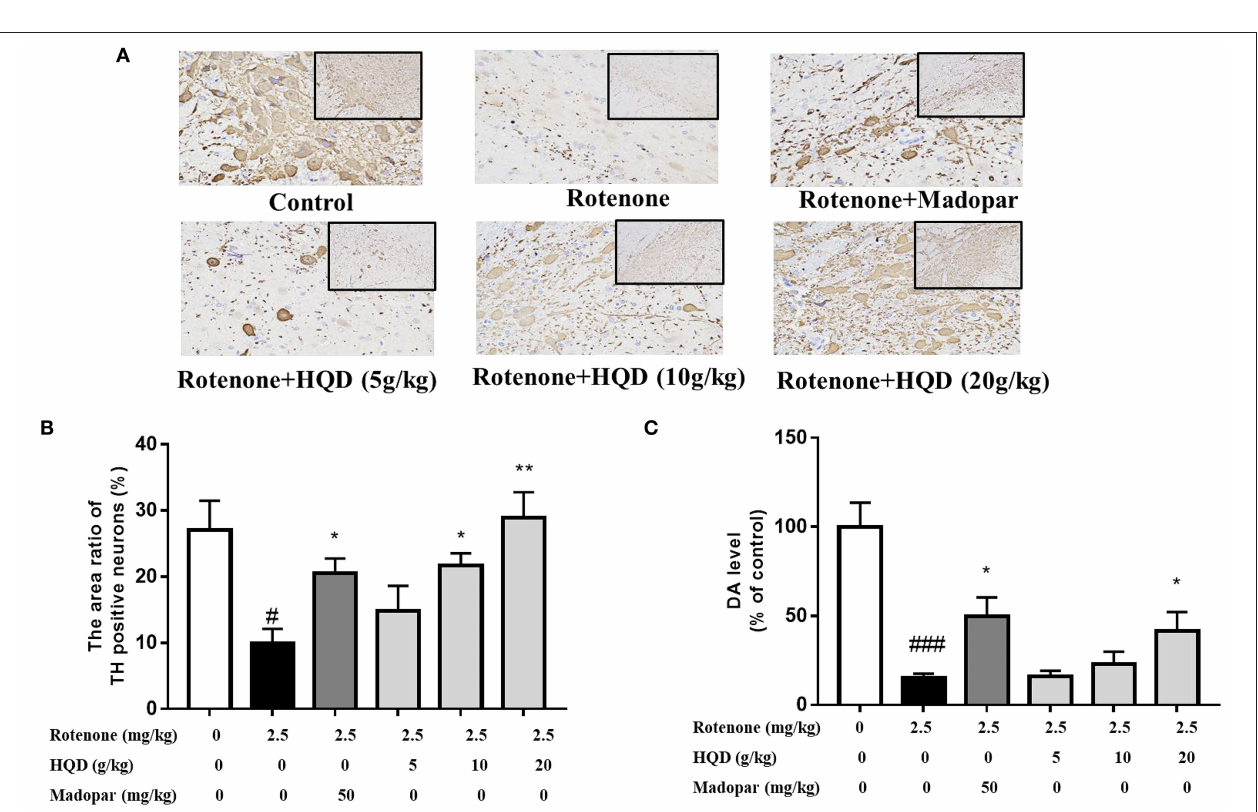
FIGURE 5 | Influence of HQD on TH-positive neurons in SN and dopamine level in striatum. (A) Representative microphotographs of TH-immunostaining neurons in the SN. (B) Quantification of the area ratio of TH-positive neurons ( n = 3). (C) The dopamine content in striatum ( n = 6). # P < 0.05, ### P < 0.001 vs. control group; ∗ P < 0.05, ∗∗ P < 0.01 vs. rotenone